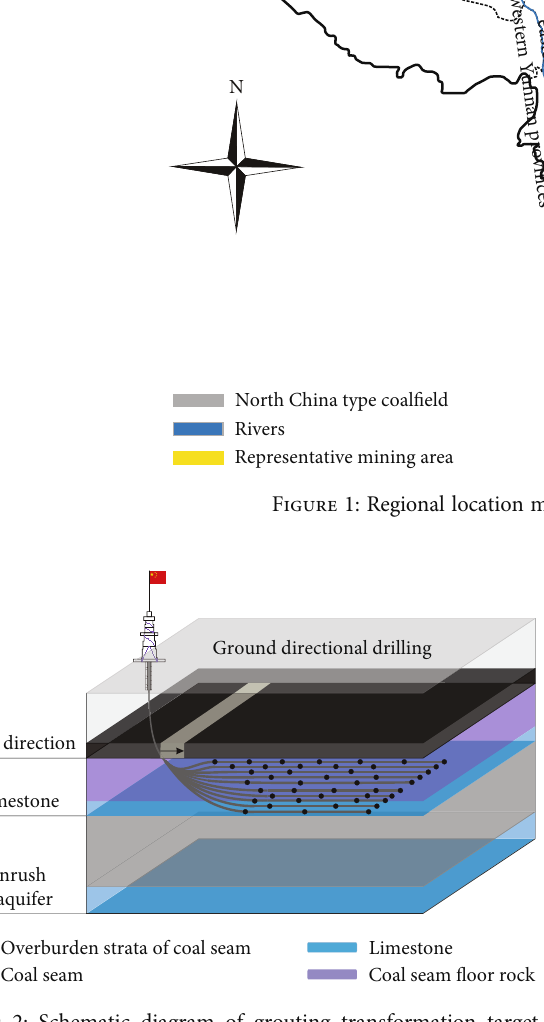
Figure 2: Schematic diagram of grouting transformation target layer of “ GCD-D.